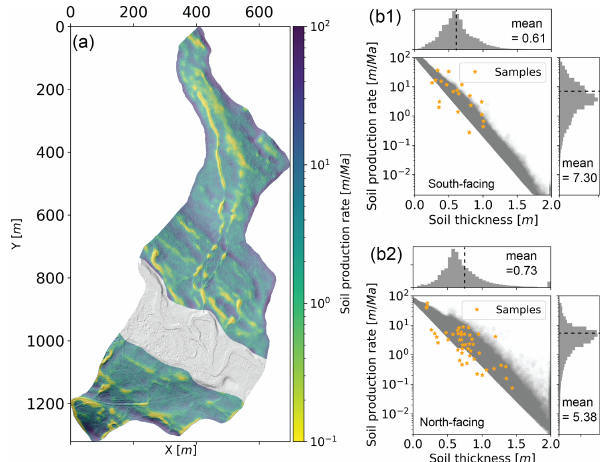
Figure 8. Map of soil production rate. (a) Spatial map of soil bot- tom (either bedrock or saprolite) production rate from modeling re- sults. (b1, b2) Relationship between soil thickness and natural log- arithm of soil production rate for the south-facing and north-facing hillslopes, respectively. The orange dots represent the soil thickness from field